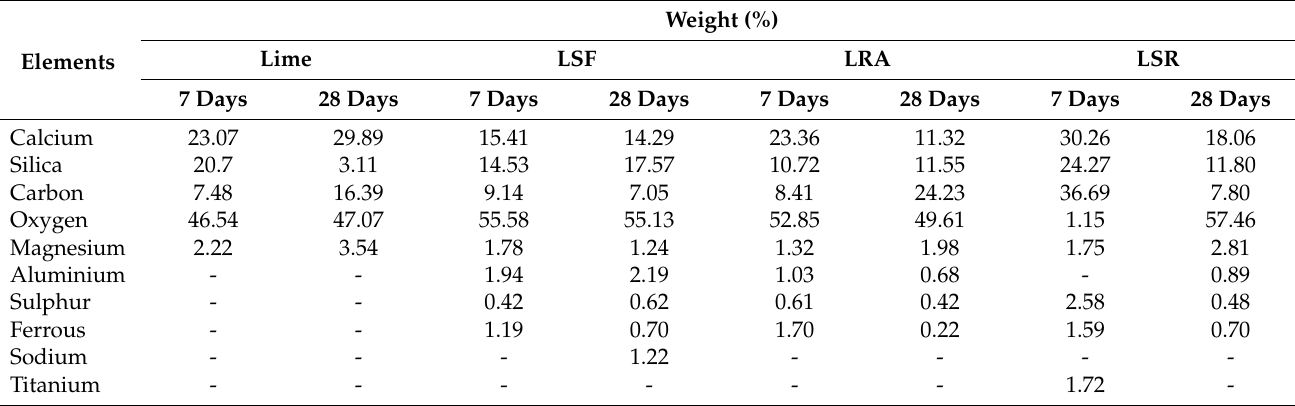
Figure 12. SEM and EDX result of lime mortar. ( a ) 7 days and ( b ) 28 days. Table 4. EDX data of lime and lime composite